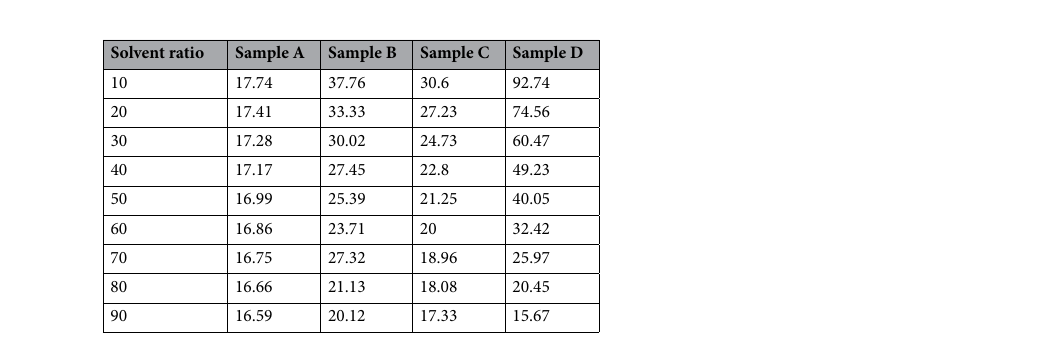
Table 4. The Volume shifts for different oil